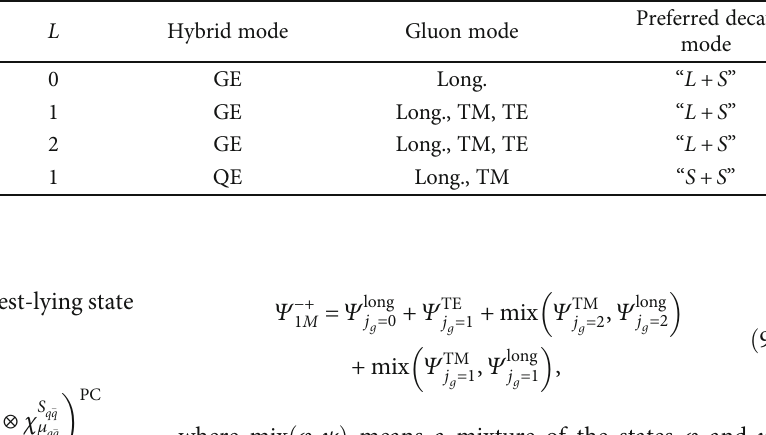
Table 2: The lowest J PC = 1 − + hybrid meson quantum numbers. Modes and the decay selection rules are